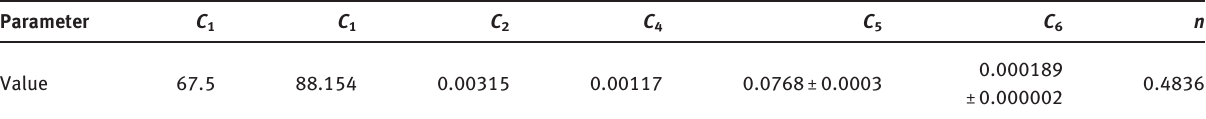
Figure 17. The values of R for the M-JC and M-ZA models are 0.985 and 0.988 [1], respectively, which are all lower than that of the DMNR model. Meanwhile, the values of AARE the M-JC and M-ZA models are 6.57 % and 6.403 % [1] respectively, which are all higher than that of the DMNR model.